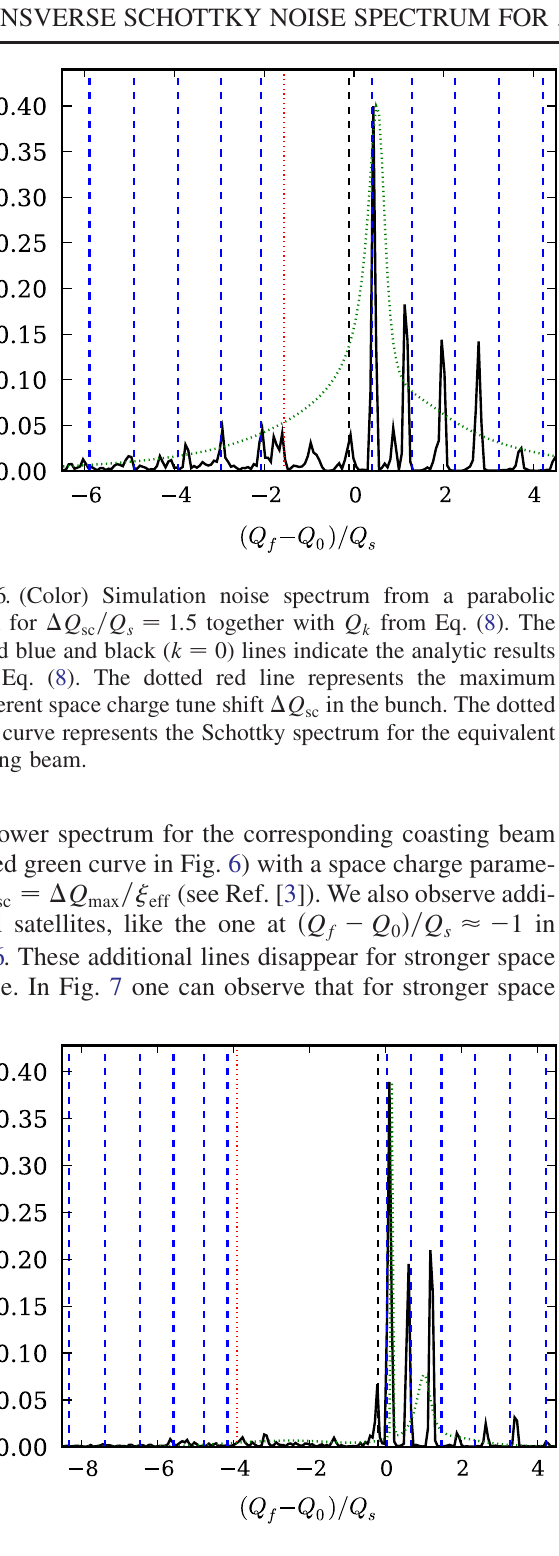
FIG. 7. (Color) Simulation noise spectrum from a parabolic bunch for (cid:1) Q sc =Q s ¼ 4 : 0 together with Q k from Eq. (8). The dashed blue and black ( k ¼ 0 ) lines indicate the analytic results from Eq. (8). The dotted red line represents the maximum incoherent space charge tune shift (cid:1) Q sc in the bunch. The dotted green curve represents the Schottky spectrum for the equivalent coasting beam.